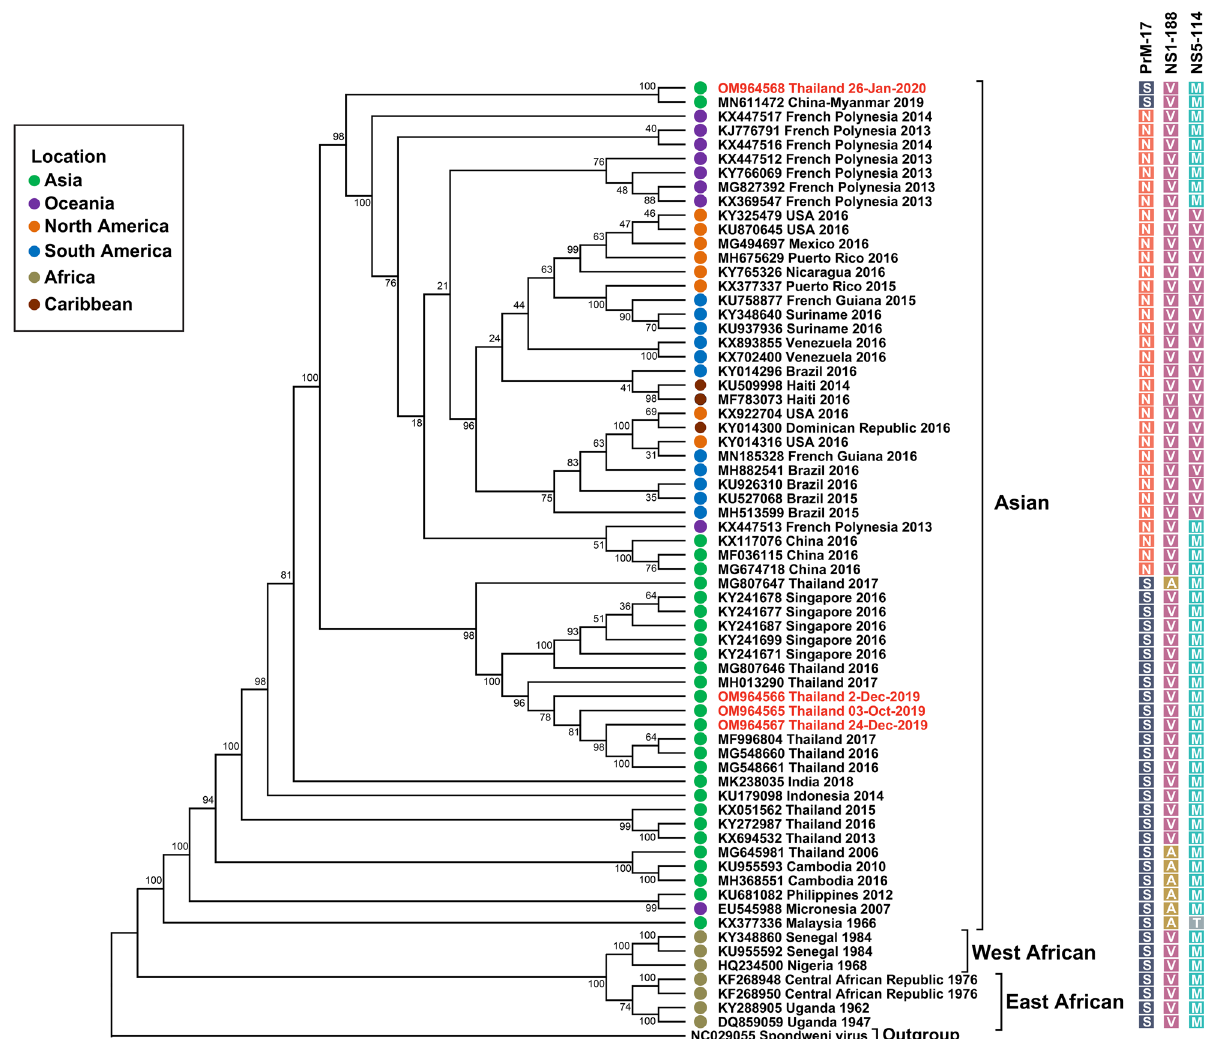
Figure 3. Phylogenetic analysis of the ZIKV complete coding sequence. The maximum-likelihood tree of ZIKV complete coding sequences was generated using the GTR + F + I + G4 model with 1000 ultrafast bootstrap replicates. Bootstrap values are indicated at branch nodes. ZIKV Thai strains from this study are shown in red. Different-colored squares show specific amino acid substitutions in prM, NS1, and